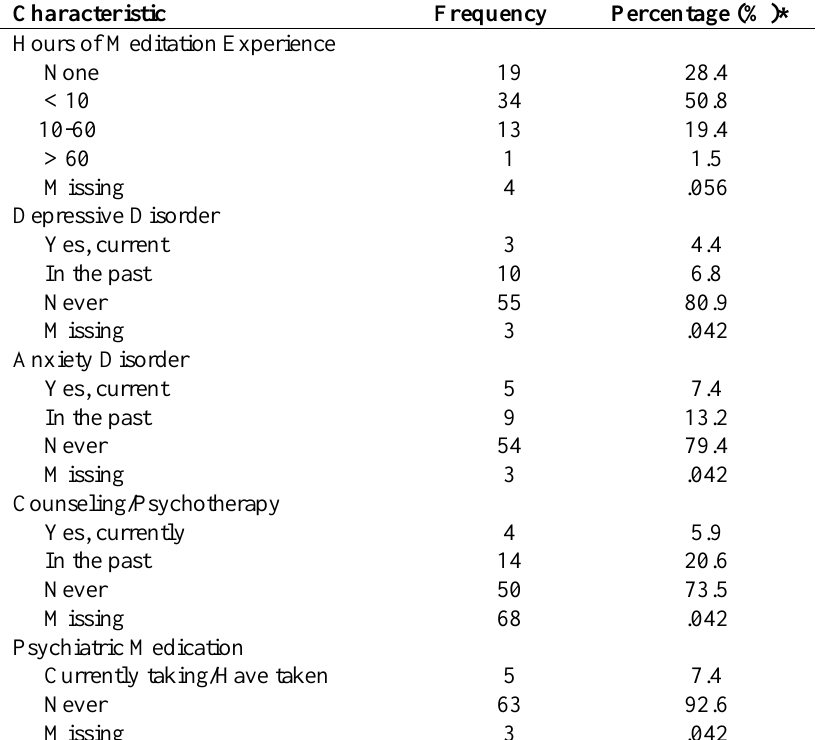
Baseline Mental Health